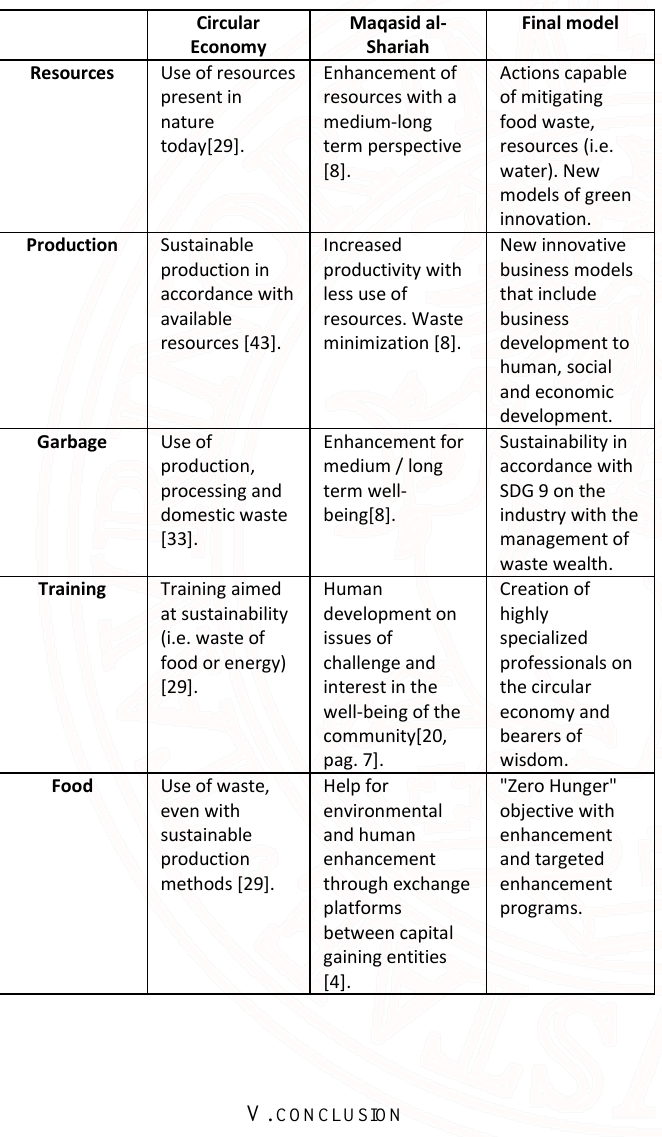
MODEL OF CIRCULAR ECONOMY BASED ON MAQASID AL - SHARIAH Circular Economy